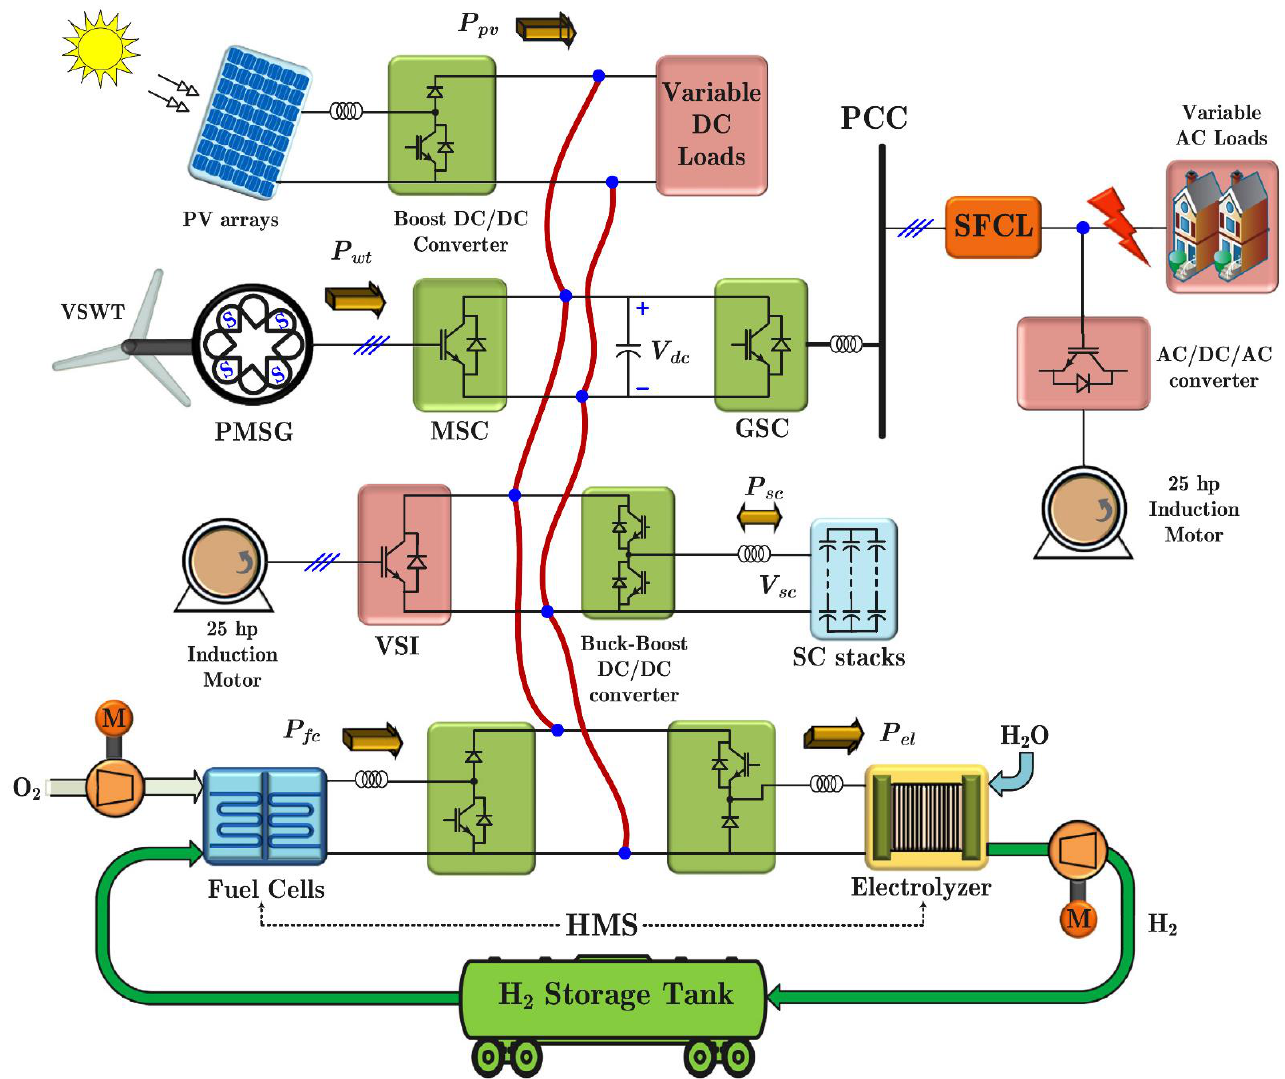
Figure 2. Configuration of a standalone hybrid AC/DC microgrid system. Reprinted with permission from Ref. [29]. 2021, Elsevier.